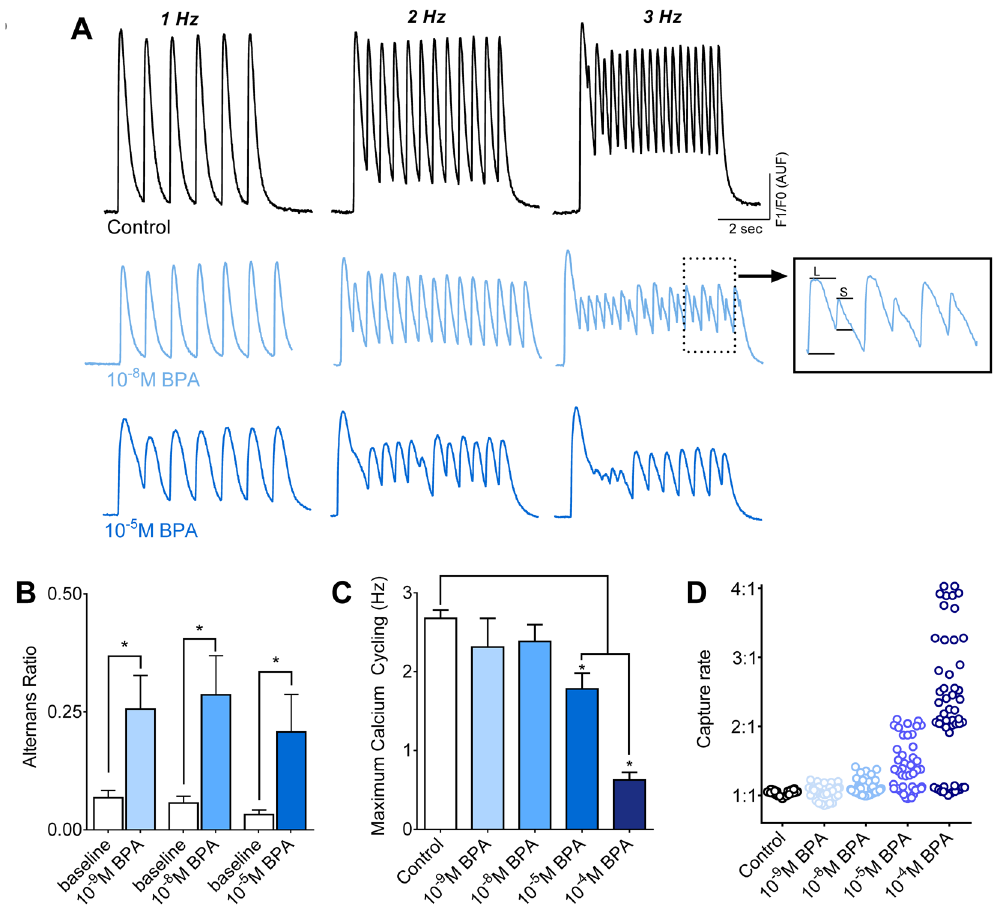
Figure 5. Acute BPA exposure promotes calcium transient alternans and impairs the rate of calcium cycling. ( A ) Pace-induced CaT recorded at multiple pacing frequencies (1–3 Hz) under control conditions, or following BPA-exposure. Representative example depicts CaT alternans with alternating long (L) and short (S) duration times following exposure to 10 − 8 M (inset). Higher BPA concentrations (10 − 5 M) slow calcium cycling, resulting in loss of capture at faster pacing rates. ( B ) Magnitude of CaT alternans expressed as a ratio [1-(CaT small/CaT large)]. ( C ) Maximum calcium cycling frequency. ( D ) Loss of 1:1 capture (2 Hz external pacing frequency). * p ≤ 0.05, n ≥